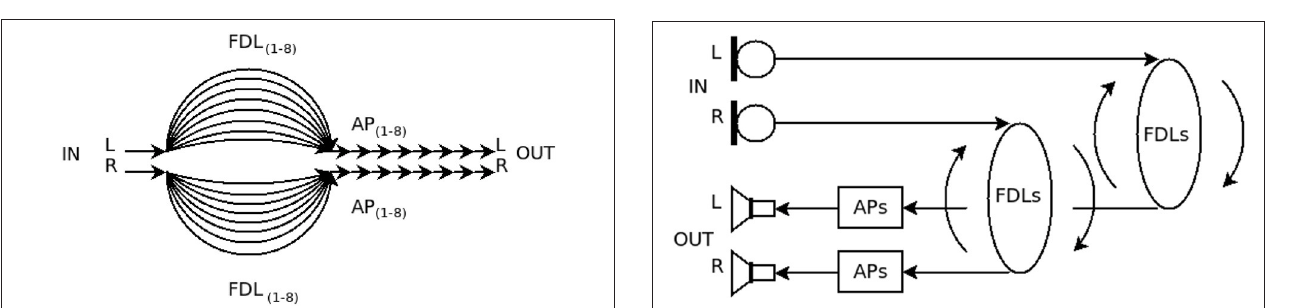
FIGURE 6 | Freeverb’s 2 × 8 FDLs and 2 × 8 All-Pass delays. FIGURE 7 | Freeverb depicted as